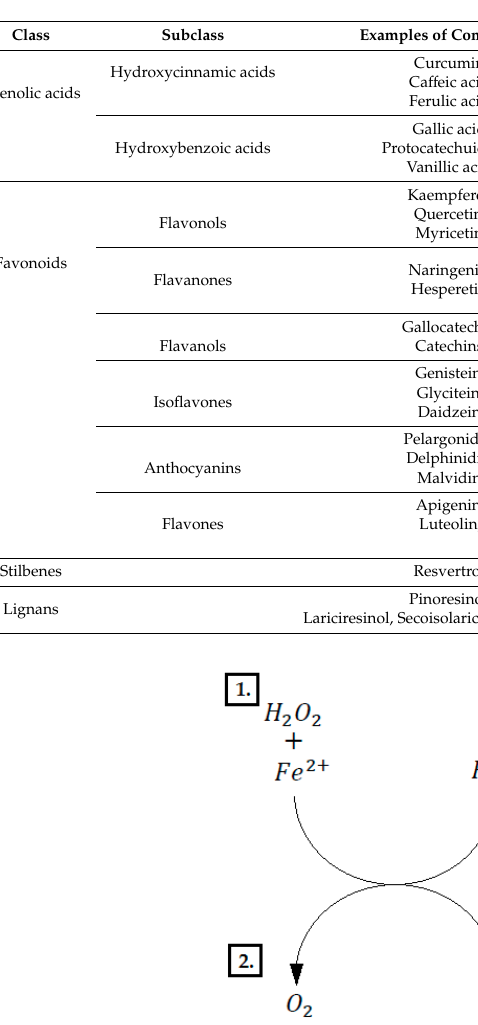
Table 1. The classification of natural polyphenols [36,37]